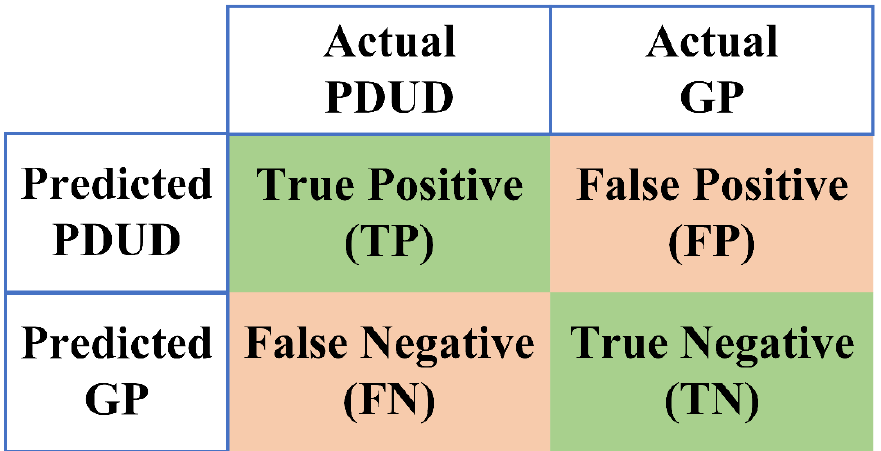
Figure B1. The definitions of true positive, false positive, false negative, and true negative. Figure A1. The definitions of true positive, false positive, false negative, and true Accuracy is the number of correctly predicted data by the model out of all the data. 𝑇𝑃 + 𝑇𝑁 𝐴𝑐𝑐𝑢𝑟𝑎𝑐𝑦 = 𝑇𝑃 + 𝐹𝑃 + 𝐹𝑁 + 𝑇𝑁